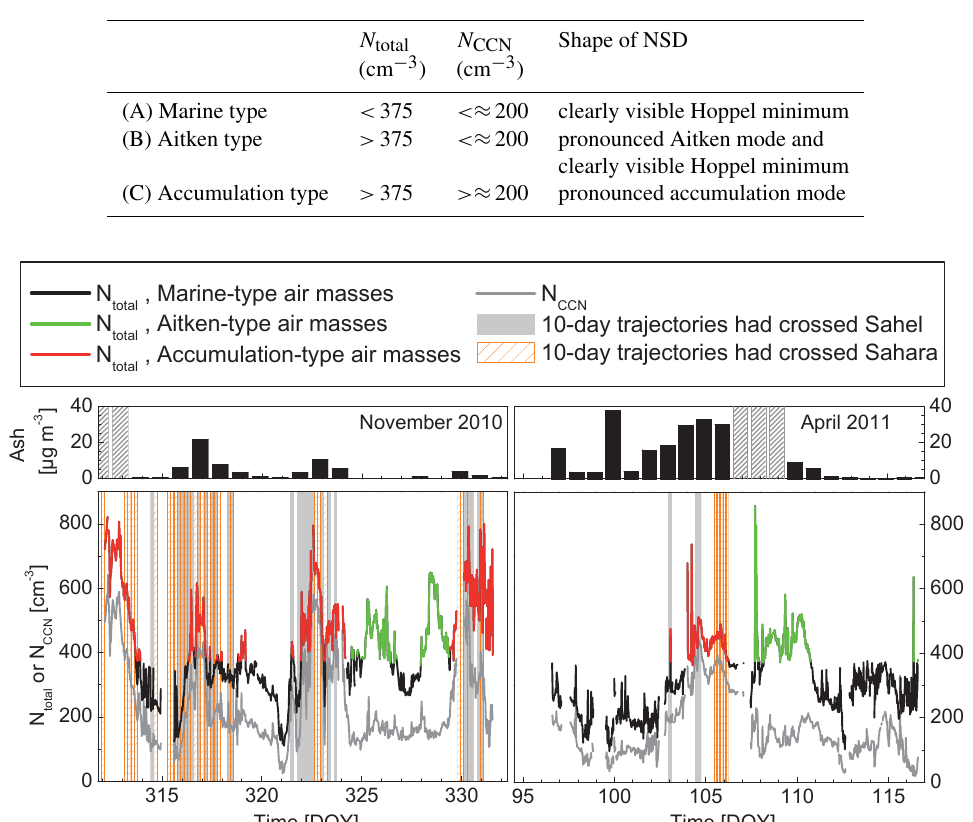
Figure 7. Time series. (Upper panels) mass of the residuals from filter samples remaining after heat treatment (ash) – grey striped areas indicate days for which no data was available. (Lower panels) N CCN (same as in Fig. 4) and N total , both derived from NSDs measured at Ragged Point. For the color coding of N total see the legend (based on the definitions of different air masses given in Table 2). The background is colored light grey or in orange stripes when trajectories indicated that air masses were advected from Africa (see the two boxes in Fig.